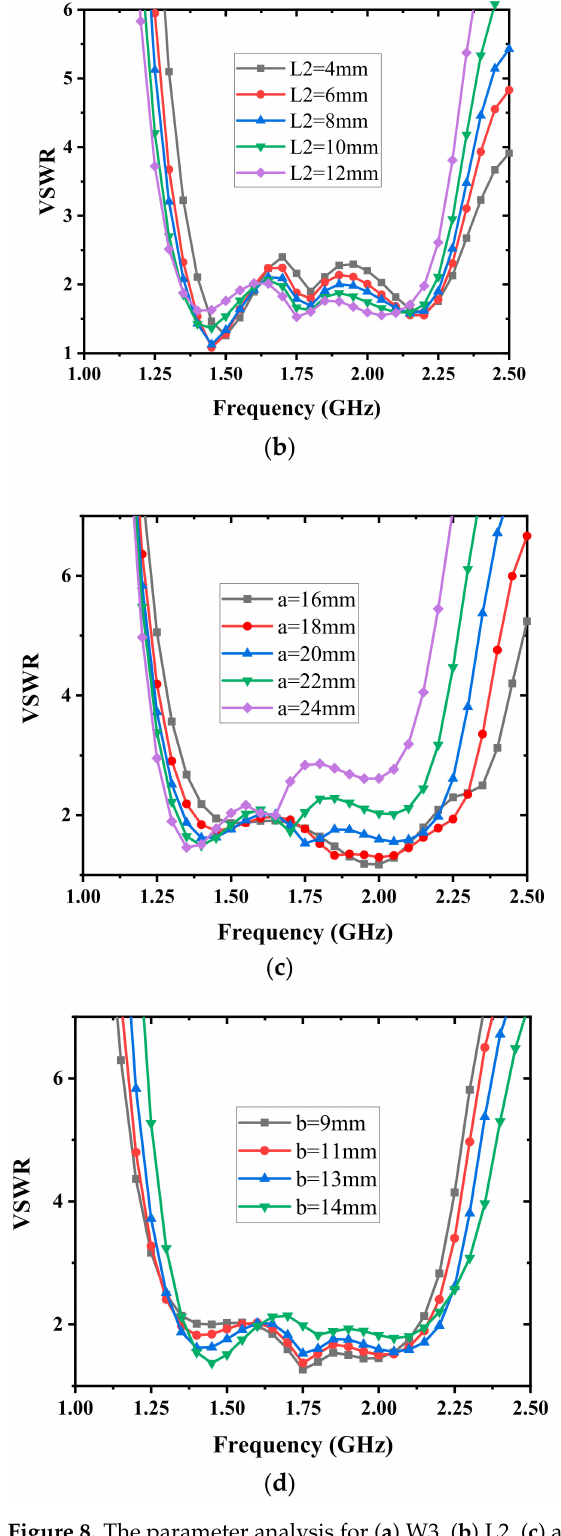
Figure 8. The parameter analysis for ( a ) W3, ( b ) L2, ( c ) a, and ( d )